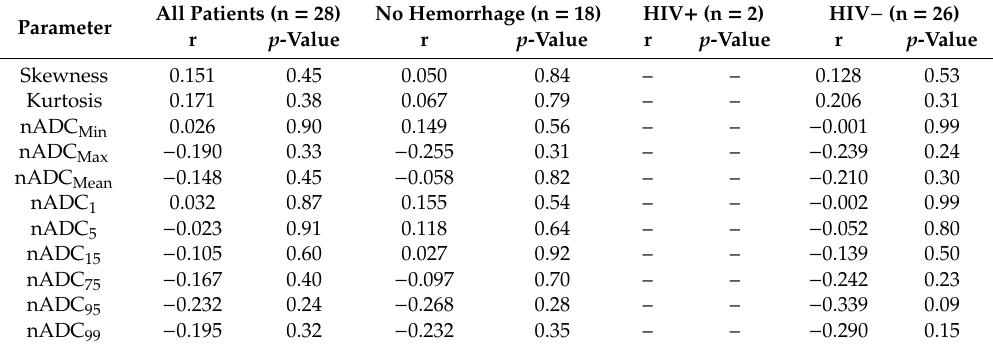
Table 3. Correlation with Ki-67 in patients with available data. Results are considered significant (*) when p <